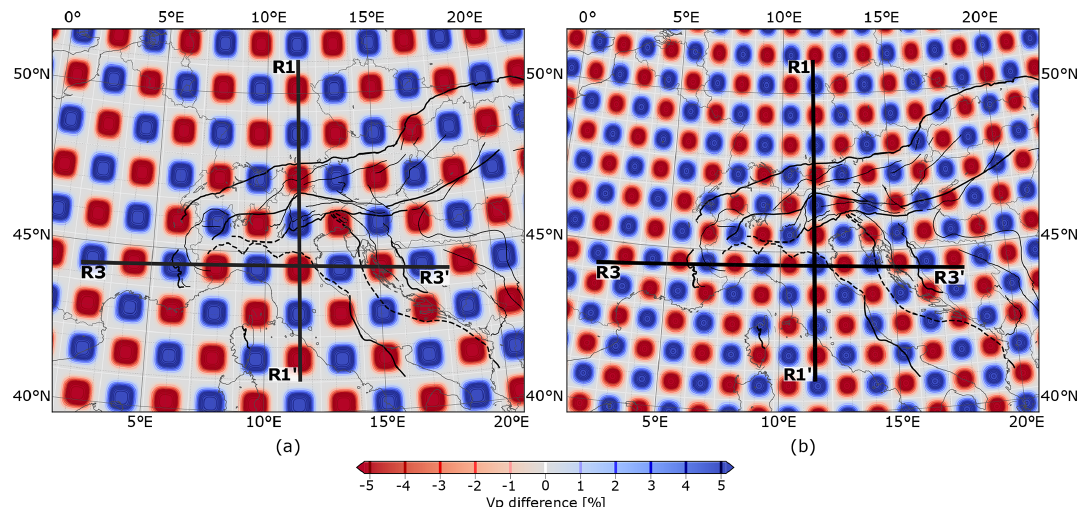
Figure 7. Horizontal slice cutting through the centre of the uppermost anomaly layer of the two checkerboard models. Depth of the first slice (a) of the 3 × 3 × 4 model is 150km. Depth of the slice through the 2 × 2 × 3 model (b) is 175km.